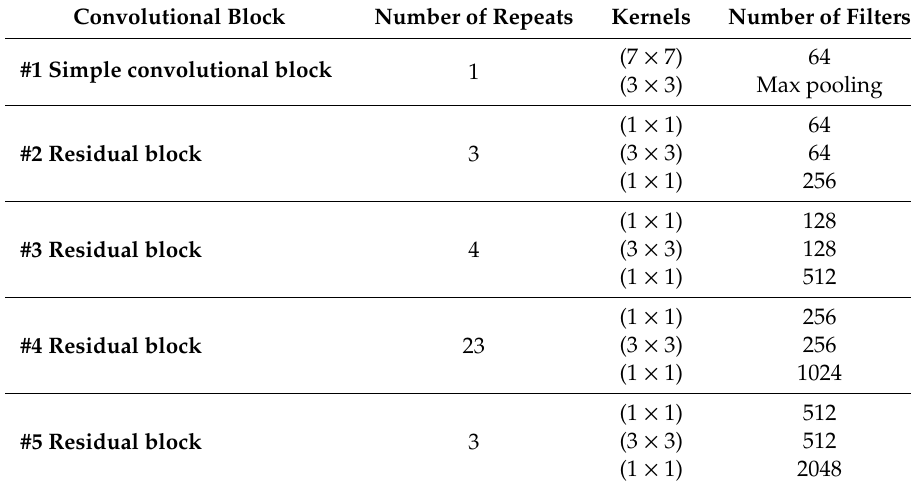
Table 1. ResNet-101 deep feature extractor layers’ characteristics.